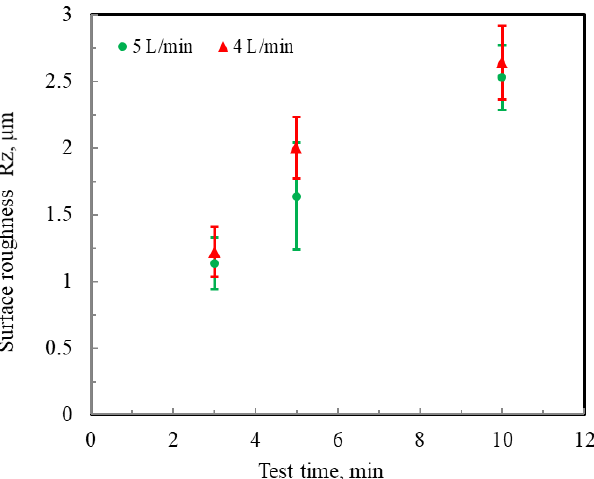
Figure 11. Change in the surface roughness R Z as a function of the exposure time in the bubbling conditions with different air-flow rate .